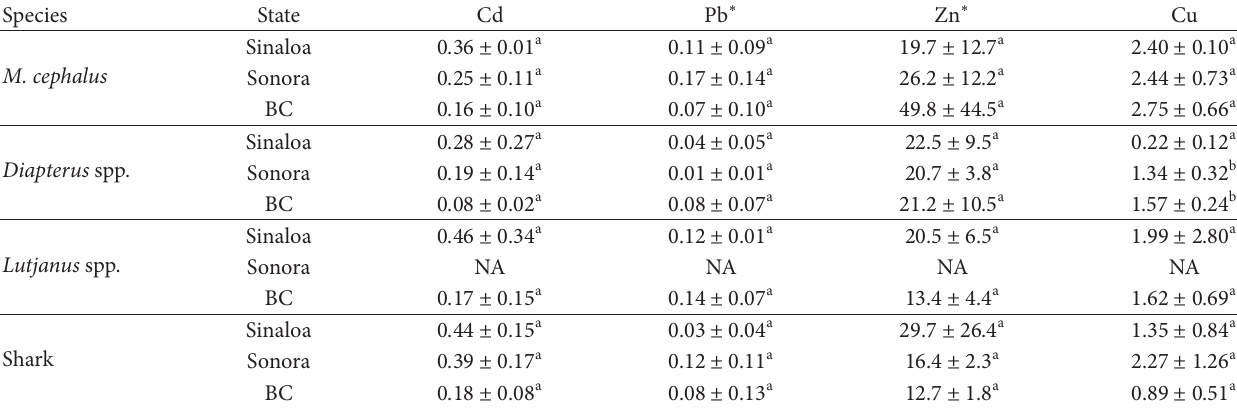
Table 1: Mean ( ± standard deviation) of the metal concentrations ( 𝜇 g g − 1 , dry weight) in edible muscle of fishes from markets of NW Mexico (one composite sample/market: 𝑛 = 3 for each state).